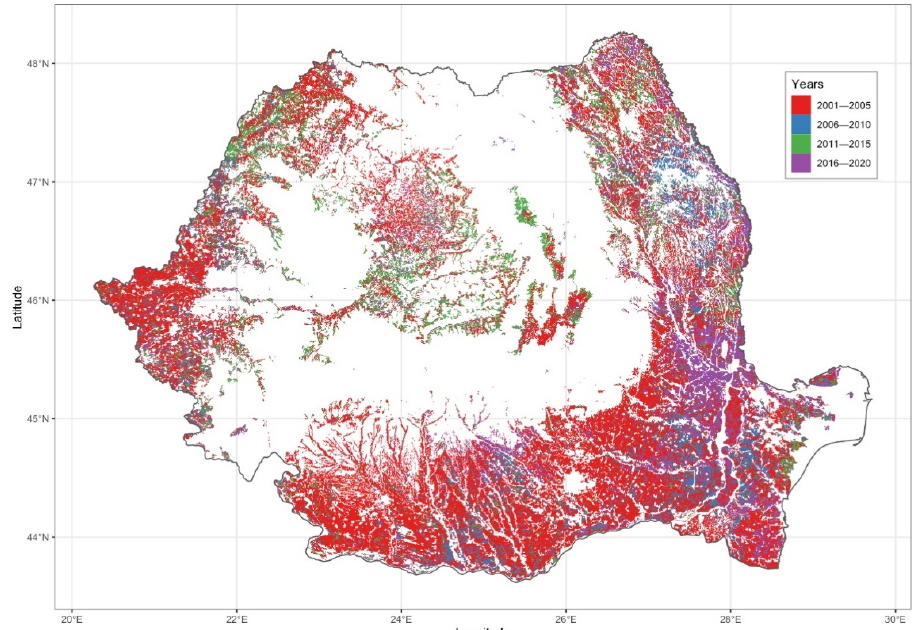
Figure 5. The year recording the highest value of the NDDI for each pixel in Romania for 2001– 2020.